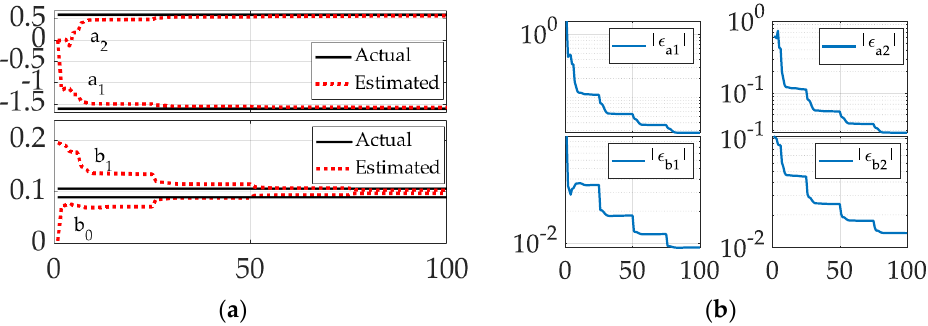
Figure 4. Indirect self-tuner without process zero cancellation (minimum phase plant) with timesteps on the abscissa. ( a ) arameter estimation. ( b ) Extended least squares’ estimation of the residuals or innovations.